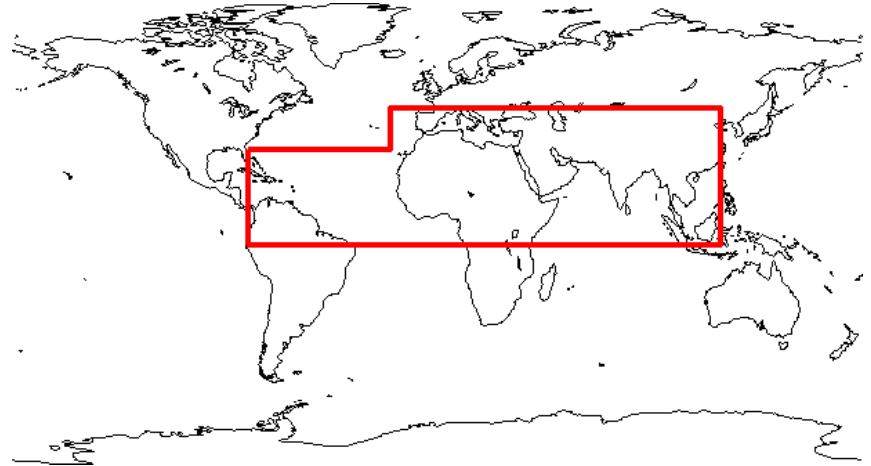
Figure 1. Map of the world with the red box defining the dust belt area where all MAPIR retrievals are undertaken (if cloud fraction is smaller than 10% and no problem with input level 1 and level 2 data is